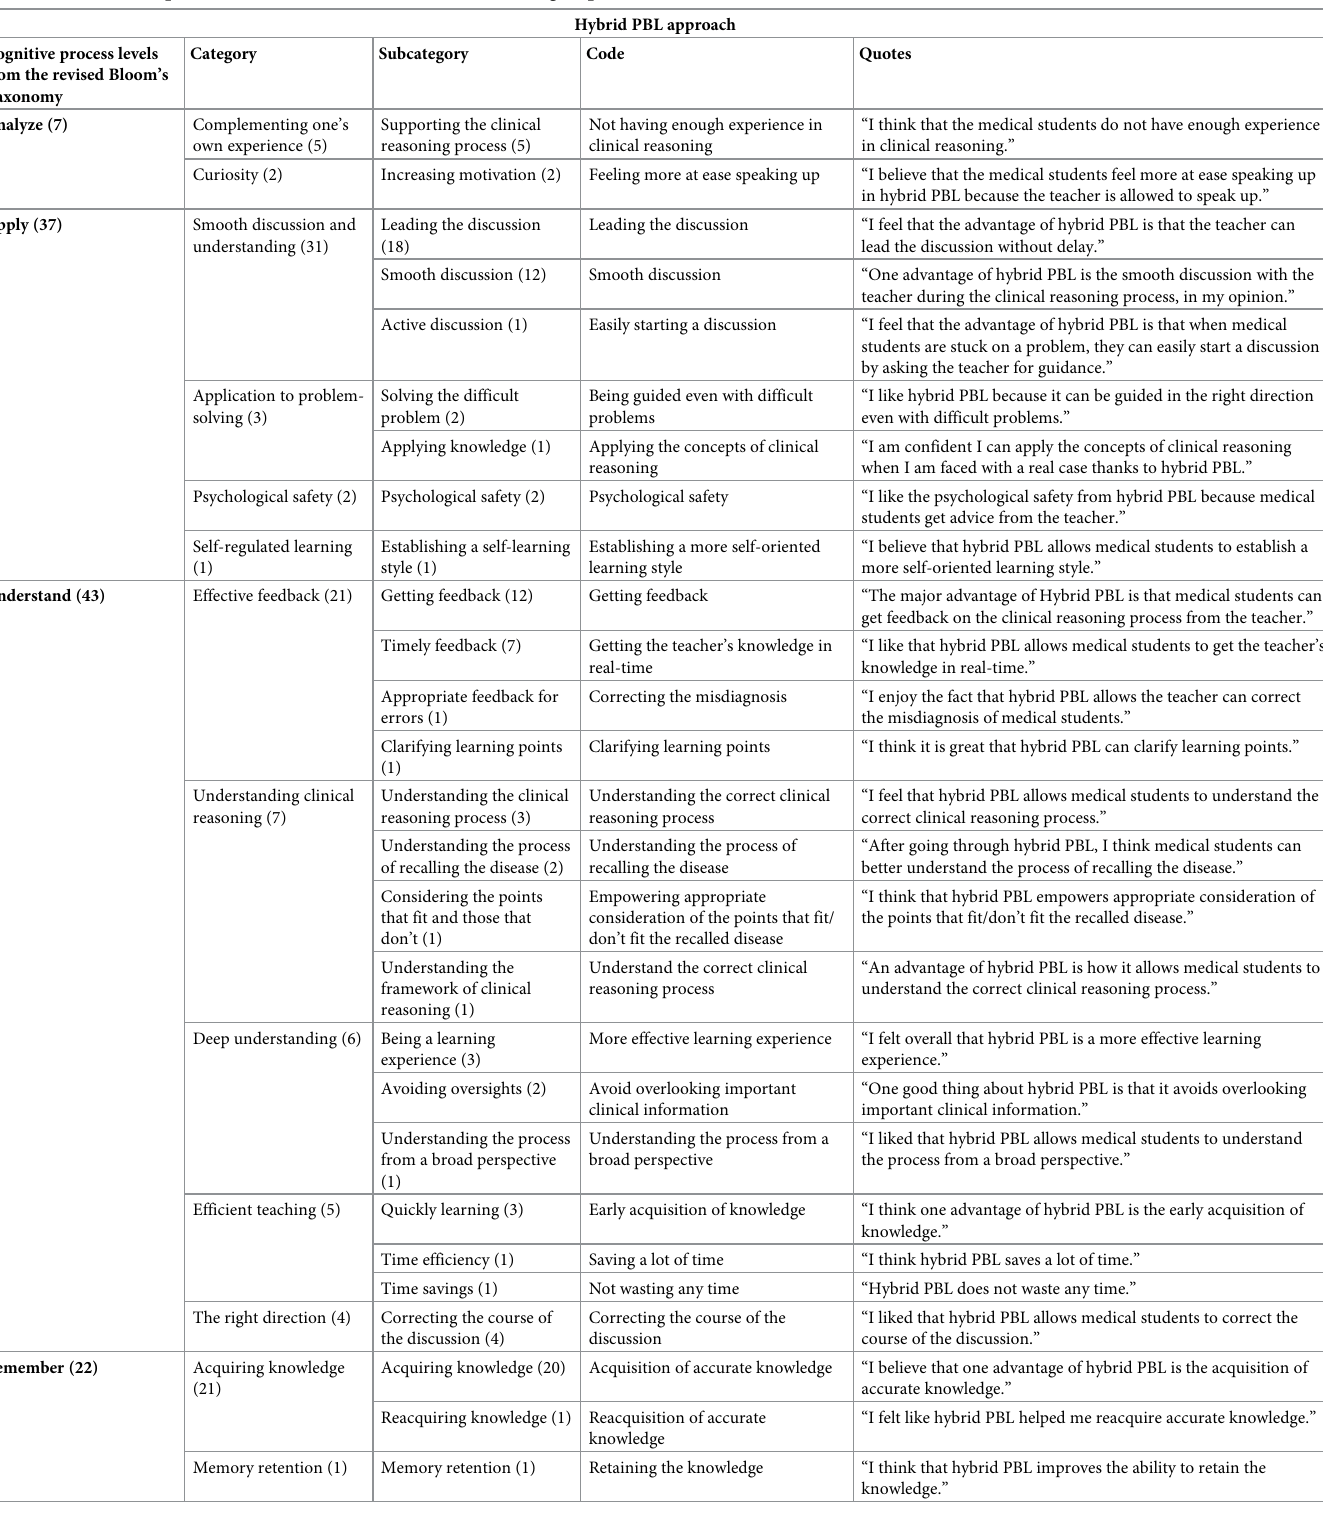
Table 7. Absolute frequencies of codes for each theme (intervention